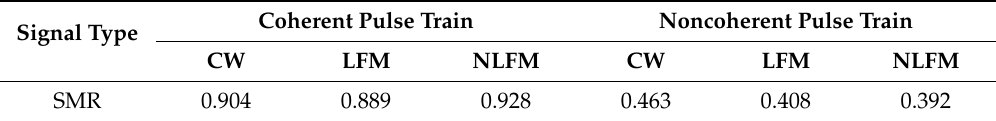
Table 1. Results of the secondary peak value to the main peak value (SMR) with di ff erent signal